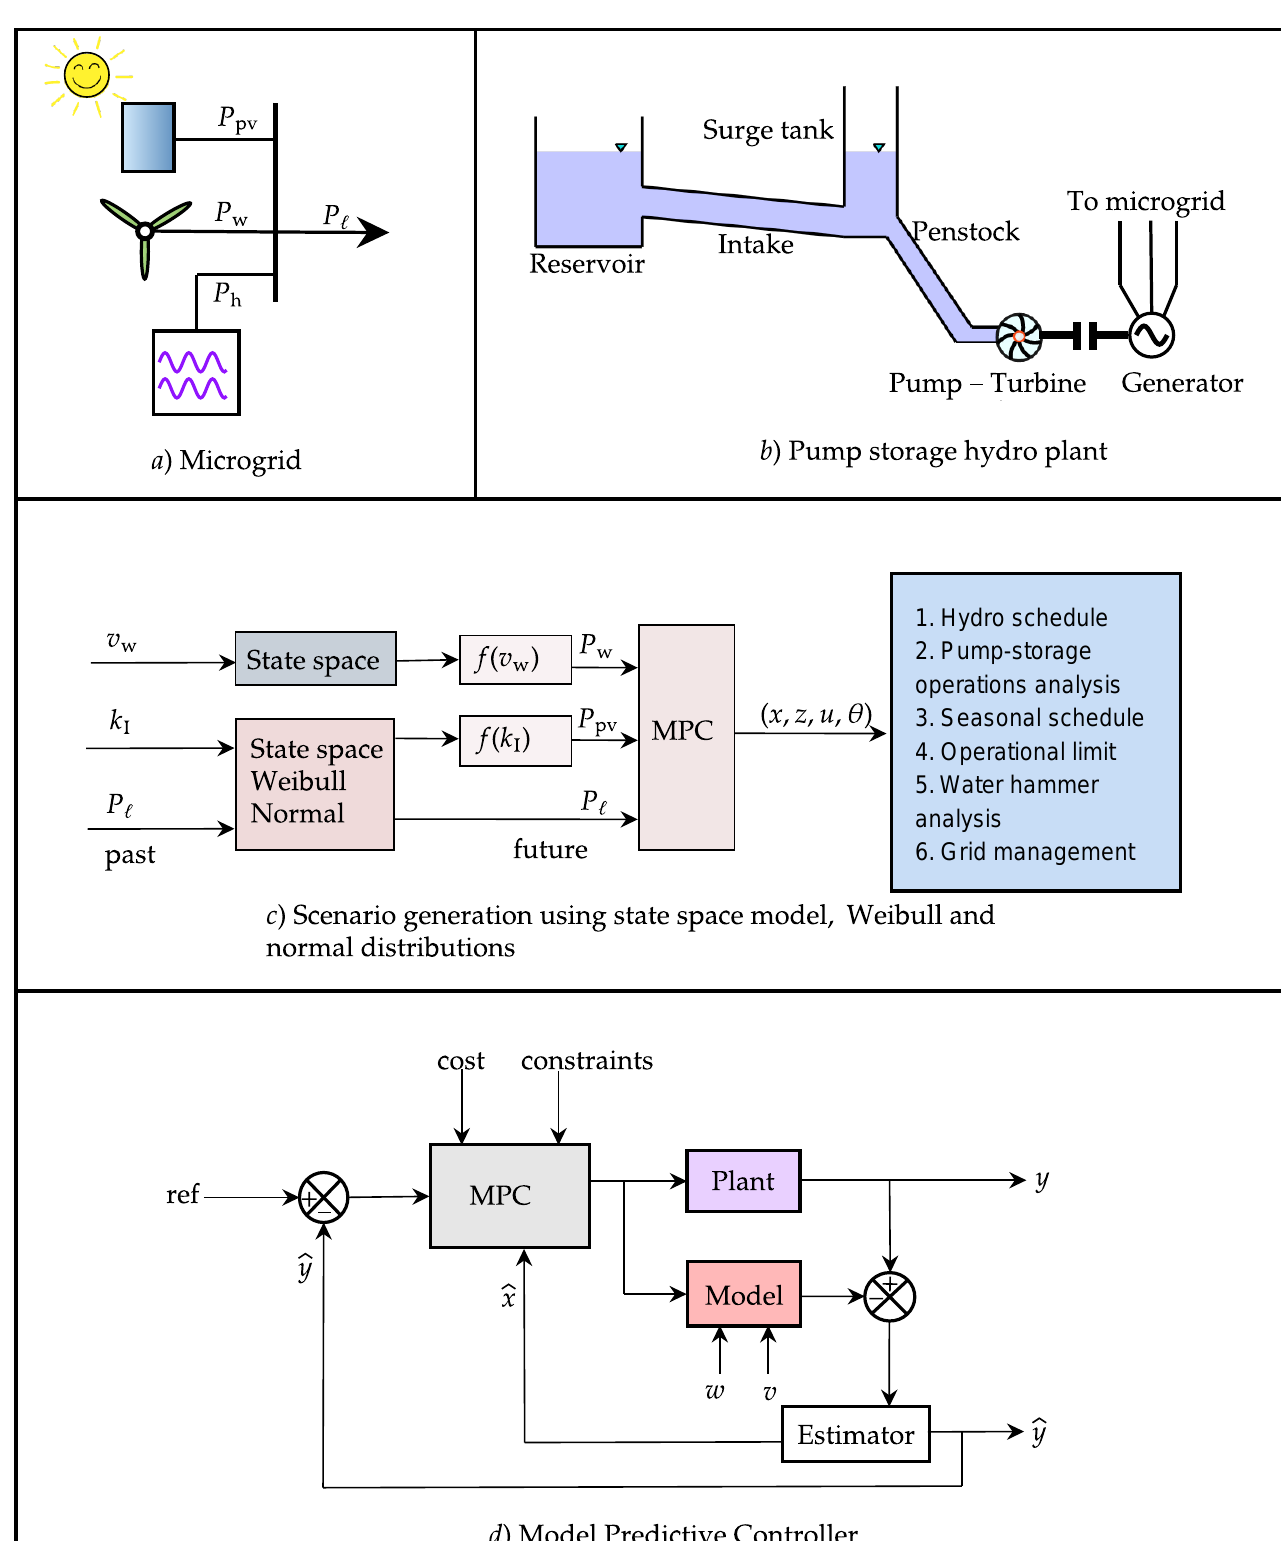
Figure 1. System block